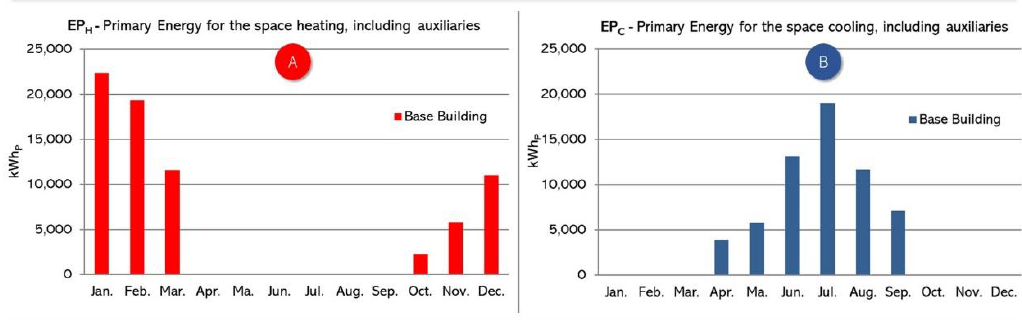
Figure 4. Heating and cooling primary energy demand.